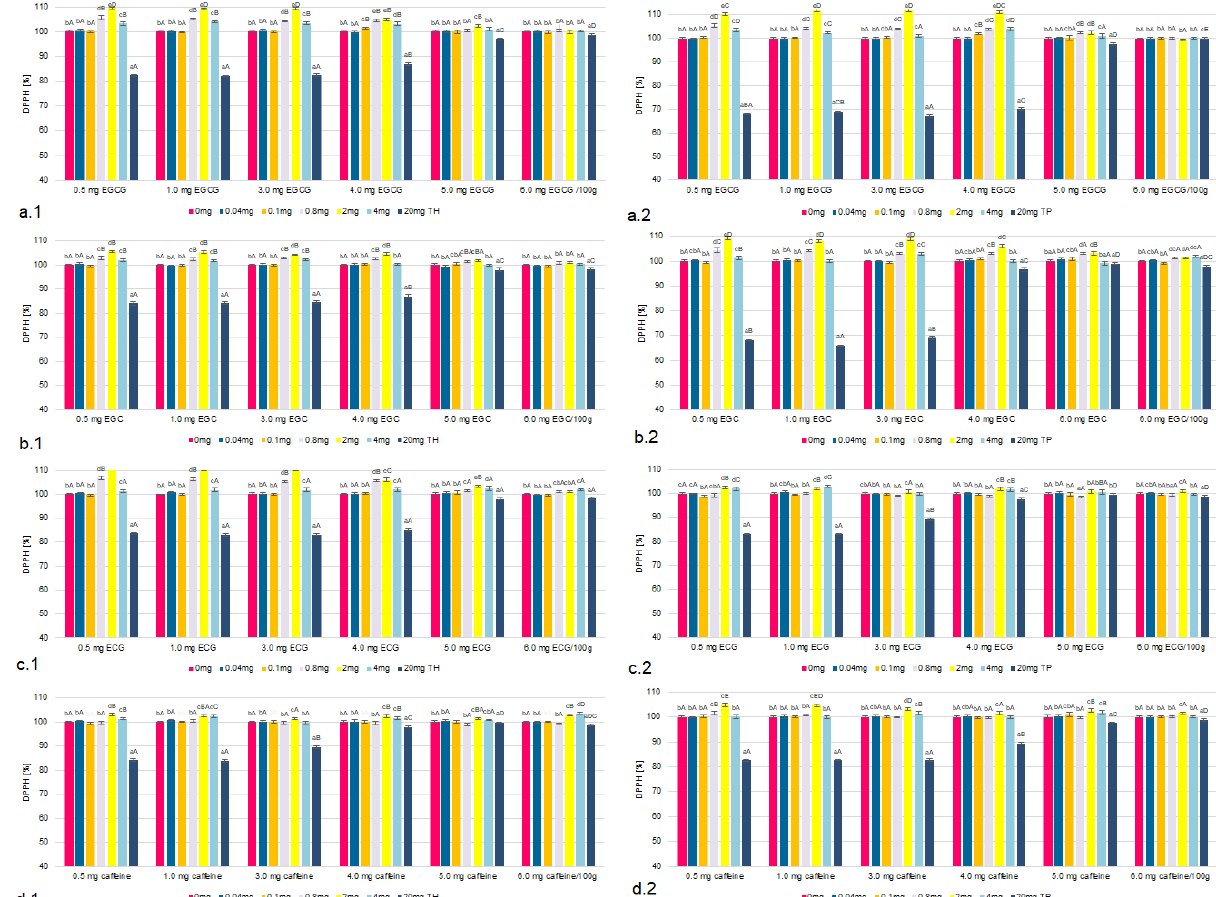
Figure 3. The DPPH scavenging capacity of EGCG ( a ), EGC ( b ), ECG ( c ) and caffeine ( d ) in the models with TH ( 1 ) and TP ( 2 ), compared to a sample without thiamine; different letters (lower letters in the same concentration of antioxidant; bold letters in the same concentration of thiamine denote a significant difference at p < 0.05 (one-way ANOVA, and post hoc Tukey